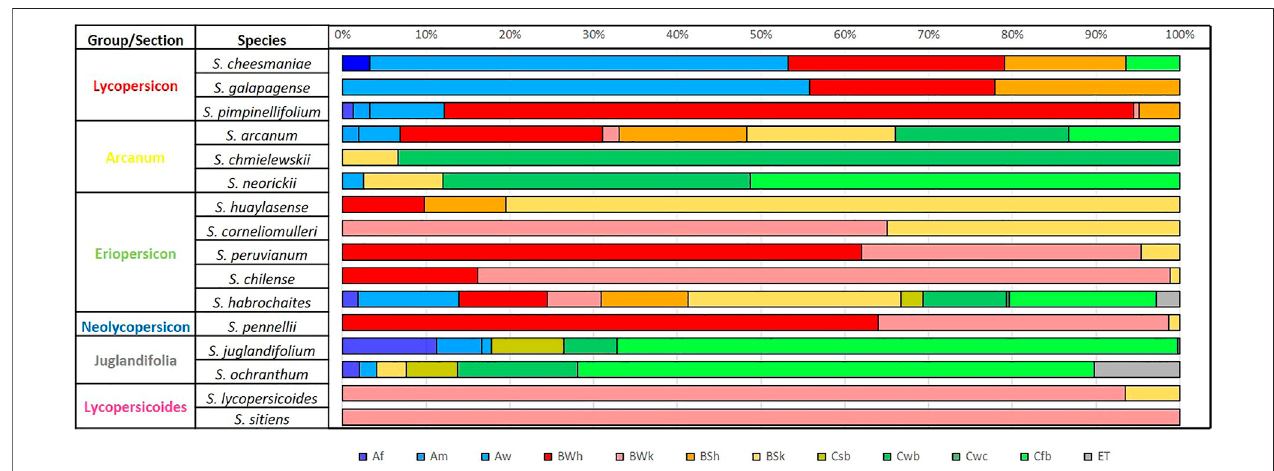
FIGURE 6 | Percentage of climate type by species according to Beck et al. (2018) of 12 wild tomato ( Solanum Sect. Lycopersicon) and 4 closely related species ( Solanum Sect. Juglandifolia and Sect. Lycopersicoides). Climate type: Af (tropical, rainforest), Am (tropical, monsoon), Aw (tropical, savannah), BWh (arid, desert, hot), BWk (arid, desert, cold), BSh (arid, steppe, hot), BSk (arid, steppe, cold), Csb (temperate, dry summer, and warm summer), Cwb (temperate, dry winter, and warm summer), Cfb (temperate, no dry season, and warm summer), ET (polar, frost).